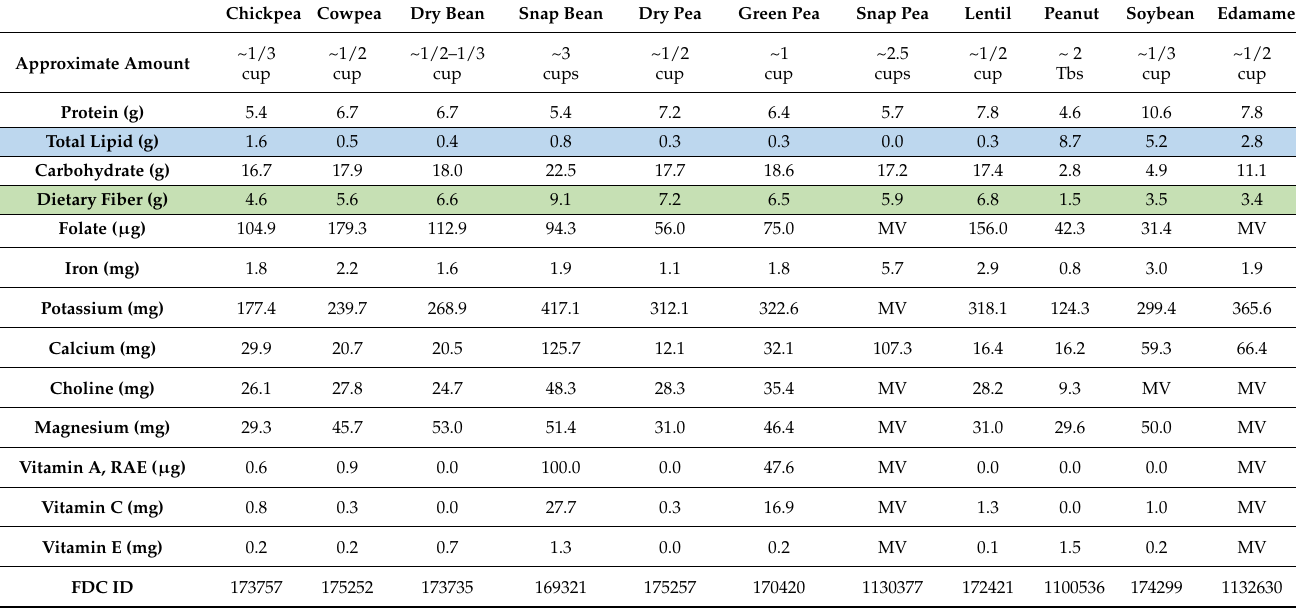
Table 1. Nutritional analysis of 100 kilocalorie portions of the predominant pulses, undried legumes, and oilseed legumes. Chickpea Cowpea Dry Bean Snap Bean Dry Pea Green Pea Snap Pea Lentil Peanut Soybean Edamame